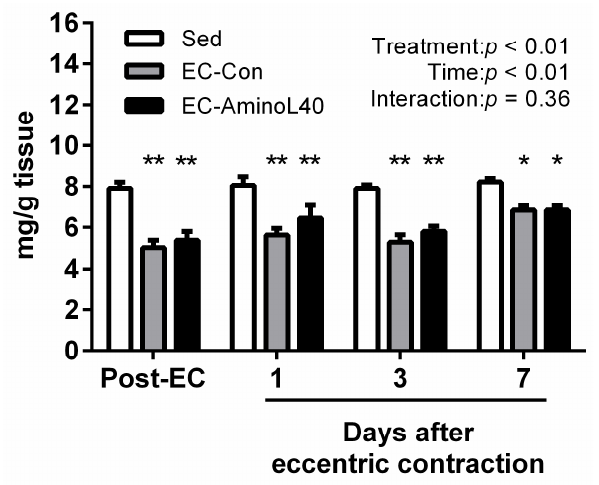
Figure 1. Muscle glycogen content in the tibialis anterior (TA) muscle immediately after eccentric contraction (Post-EC), 1, 3, and 7 days later. Muscle glycogen content was measured in the sedentary group (Sed), and in rats who underwent eccentric contractions and were given water (EC-Con) or a leucine-enriched essential amino acids mixture (EC-AminoL40). Data represent the mean ± SEM ( n = 4 (Sed) or 5 (EC groups)); * p < 0.05 vs. Sed group, ** p < 0.01 vs. Sed group, # p < 0.05 vs. EC-Con group.